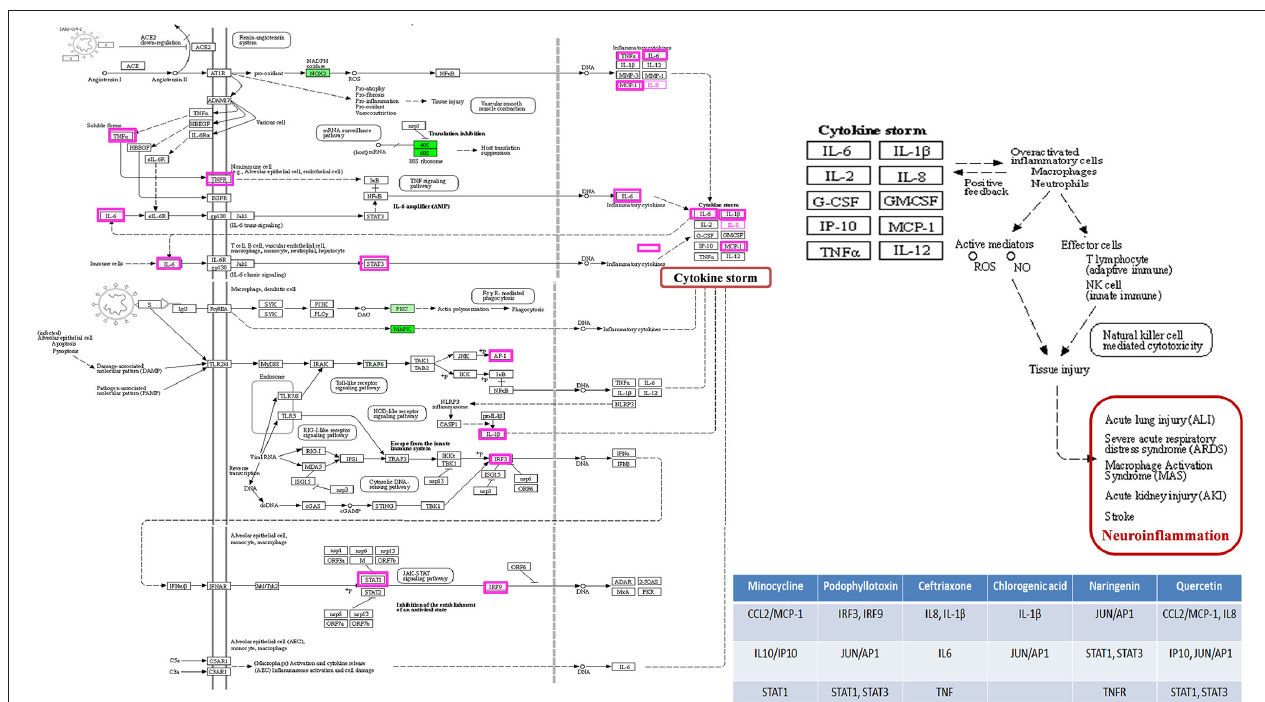
FIGURE 14 | The KEGG pathway of Coronavirus Disease. The critical genes identified with CytoNCA are highlighted, and their role in cytokine storm-mediated neuroinflammation is